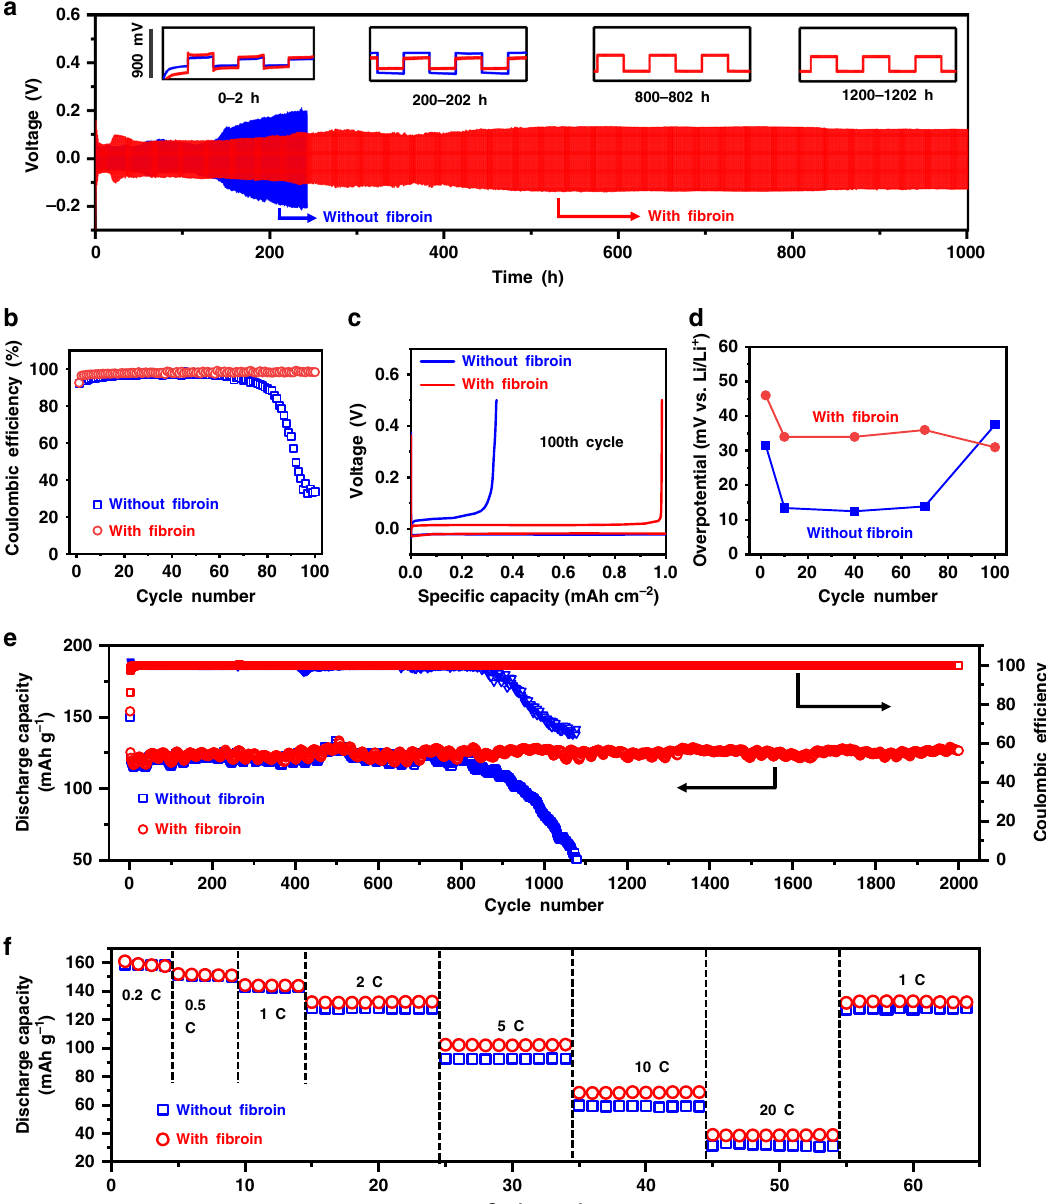
Fig. 4 The electrochemical performance of Li anode in ether-based electrolyte with or without a fi broin interlayer. a Galvanostatic cycling of symmetric Li | Li cells with (blue line) or without (red line) a fi broin interlayer. The current density is fi xed at 3 mAcm − 2 with a plating/stripping capacity of 1mAhcm − 2 . Insets: The blow-up of voltage pro fi les during 0 – 2, 200 – 202, 800 – 802, and 1000 – 1002 h, respectively. The y -axis scale of the insets is shown on the left. b Comparison of cycling performances of Li | Cu half-cells with or without a fi broin interlayer between Cu foil and separator. The amount of Li deposited in each cycle is 1 mAh cm − 2 and the current density is 1 mA cm − 2 . c The corresponding voltage pro fi les at the 100th cycle of the Li plating/stripping processes on Cu foil with or without a fi broin interlayer. d Comparison of the hysteresis of Li plating/stripping for cells with or without interlayers. e Long- term cycling stability of the Li || LTO full cells with or without a fi broin interlayer at a current density of 2 C (1 C = 175 mA g − 1 ). f Rate capabilities from 0.2 C to 10 C of the Li | LTO cells with or without fi broin additive in the Electrochemical performance of Li || Li Ti O full cells . We active Li and liquid electrolyte. In contrast, the full cells with the 4 5 12 fi broin interlayer maintained an excellent capacity over 2000 further evaluated the electrochemical performances of Li || Li 4 Ti 5 O 12 (LTO) full cells with or without the fi broin interlayer. cycles. This discrepancy is further demonstrated by the voltage vs. To exclude the performance deterioration on cathodes, zero- capacity pro fi les of Li || LTO full cells (Supplementary Fig. 20). strain LTO was used as the cathode materials. The full cells with The voltage polarization of the full cells with bare Li anodes fi broin interlayer consistently exhibited better cycling stability shows an obvious increase after 1000 cycles. However, the voltage and rate capability than those without a fi broin interlayer (Fig. 4e, polarization of full cells with fi broin interlayer-protected Li anode f). As shown in Fig. 4e, the capacity of the cells with bare Li remains constant for 2000 cycles. Furthermore, as shown in Fig. 4f, the Li || LTO full cells with fi broin interlayer-protected Li anodes starts to decay after 800 cycles, indicating the depletion of